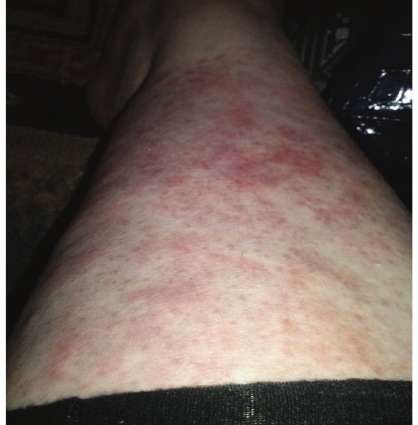
Figure 2: Maculopapular rash involving right leg.